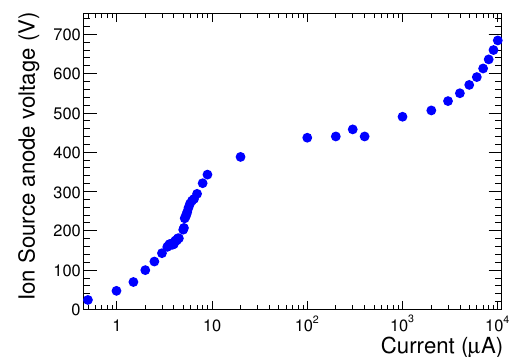
Figure 6. Current-voltage characteristic of the ion source for small discharge currents.